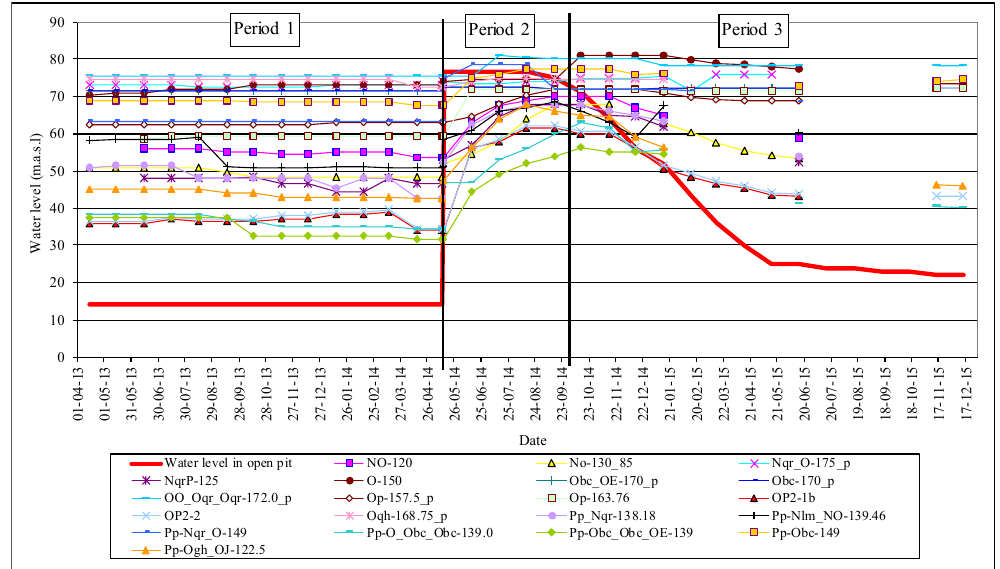
Figure 4. Water levels in the open-pit mine and groundwater levels from April 2013 to December 2015.